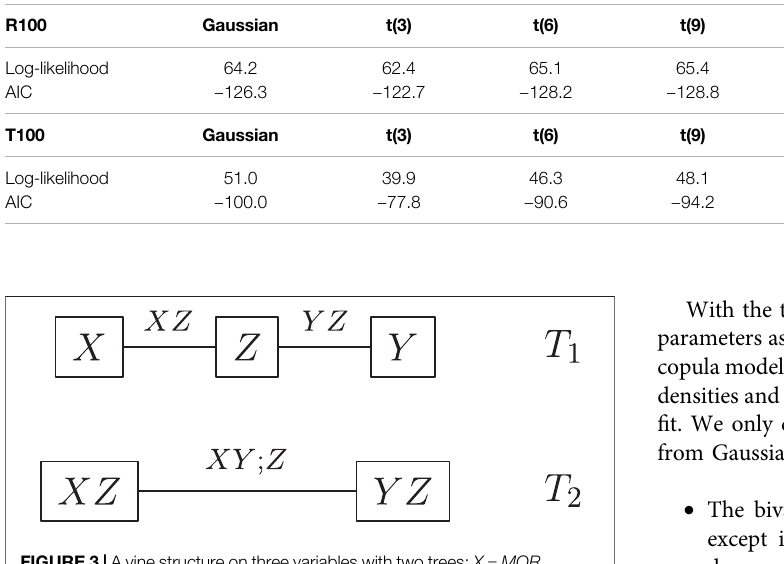
Frontiers in Applied Mathematics and Statistics |